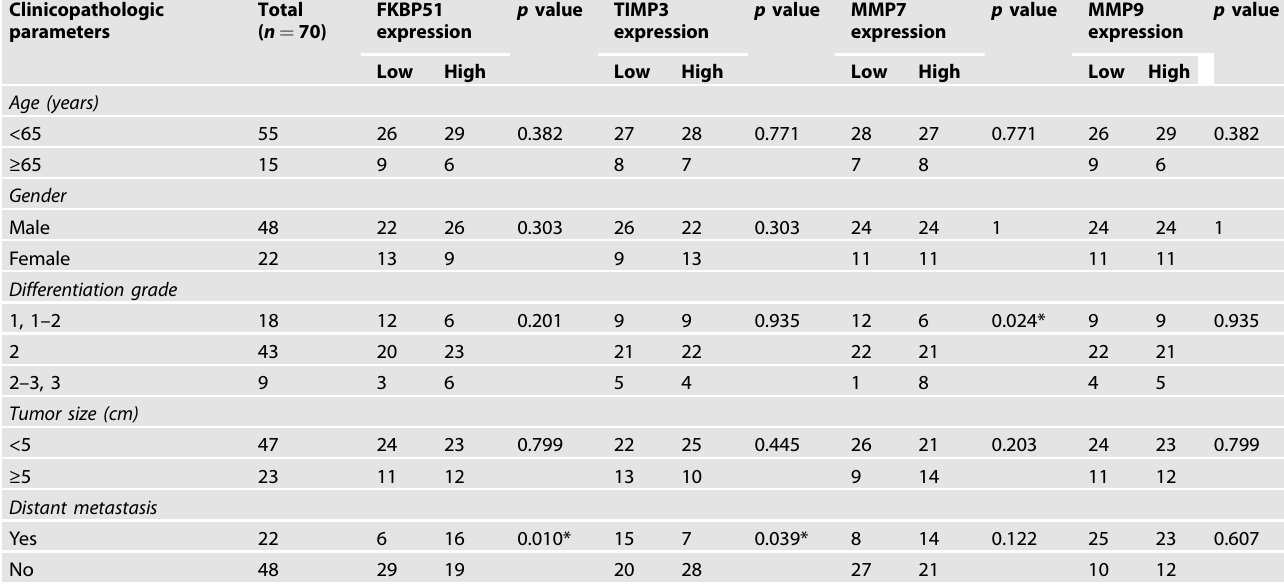
Table 1. Correlations between FKBP51, TIMP3, MMP7 and MMP9 expression and clinical